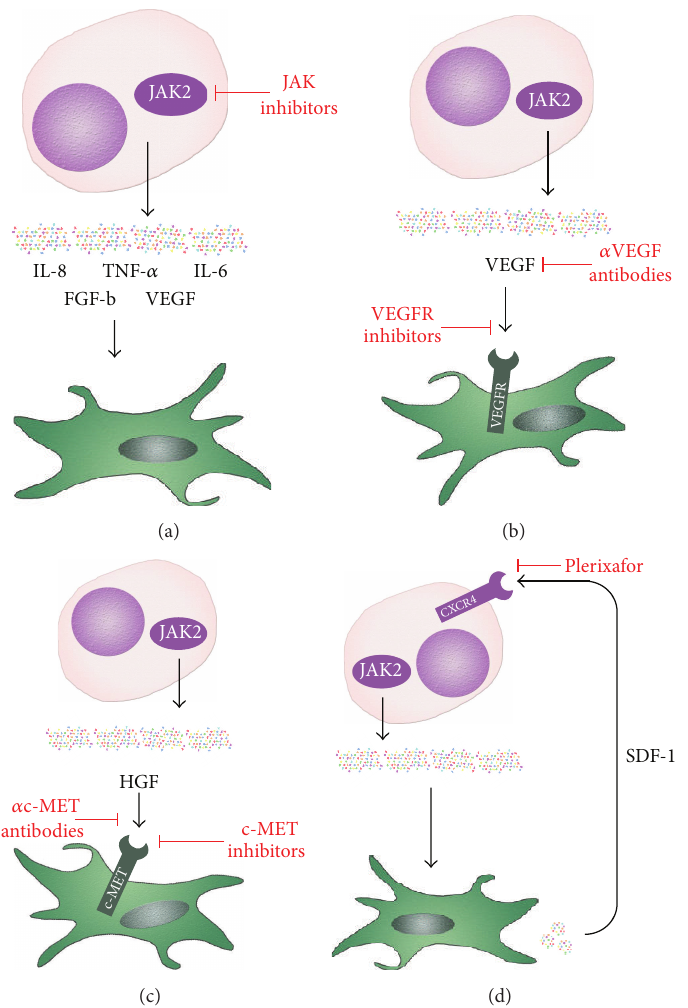
Figure2: Targetingofcytokinesandmicroenvironmentinteractioninmyeloproliferativeneoplasms. (a)JAKinhibitorsreducetheexpression of various cytokines in MPN. (b) Antibodies against vascular endothelial growth factor (VEGF) and kinase inhibitors targeting the VEGF receptors (VEGFRs) result in disruption of the VEGF/VEGFR axis. (c) Antibodies and kinase inhibitors targeting the hepatocyte growth factor (HGF) receptor c-MET attenuate the HGF/c-MET axis. (d) Plerixafor inhibits the interaction of stroma derived factor-1 (SDF-1) with its receptor CXCR4 which results in mobilization of leukemic stem